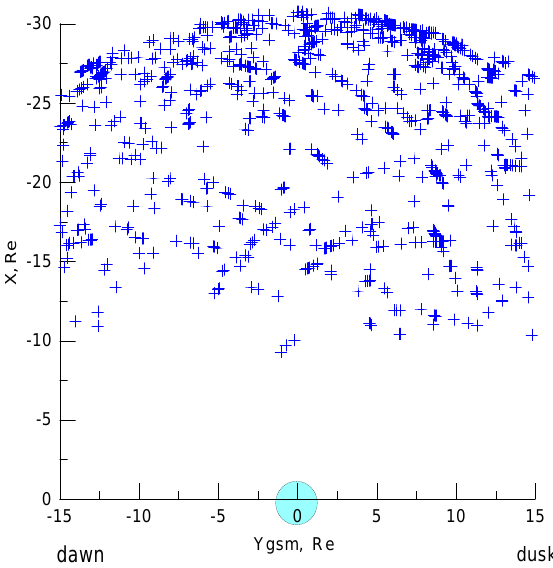
Fig. 3. Spatial distribution of fast current sheet crossings in the equatorial plane.